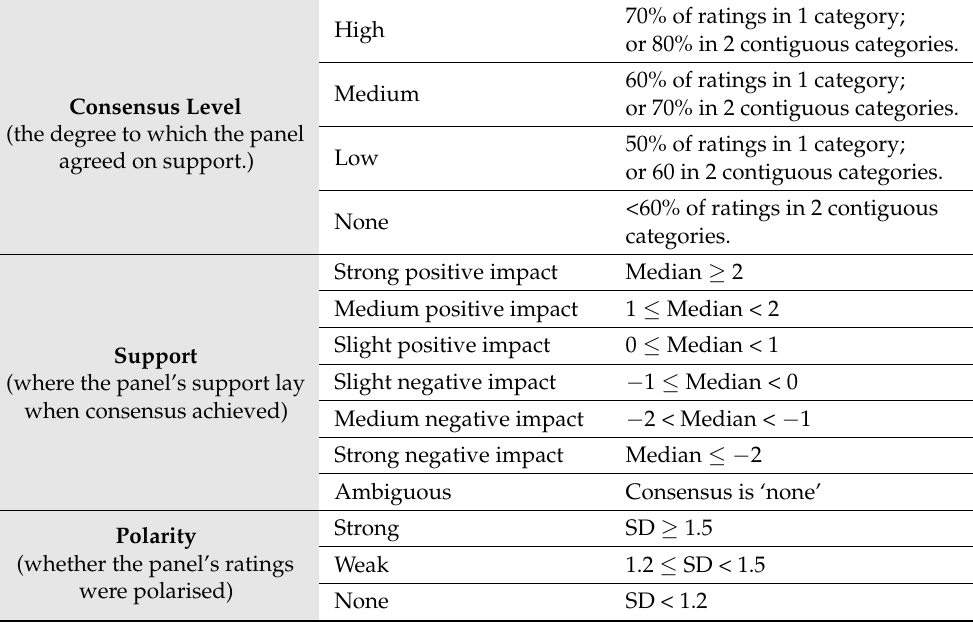
Table 6. Delphi Rating Analysis Scheme Applied in this Study.